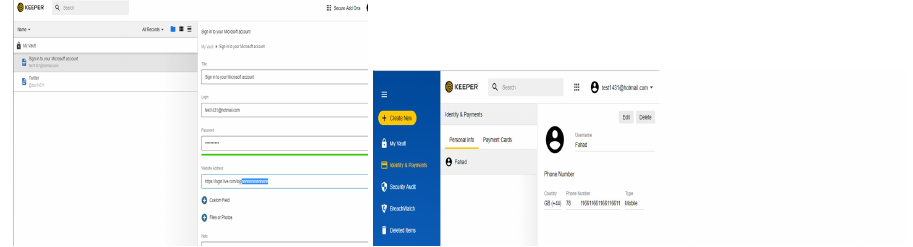
Figure A5. Keeper does not prevent users from storing wrong data, for example, incorrect URL and phone no (part of phone number is